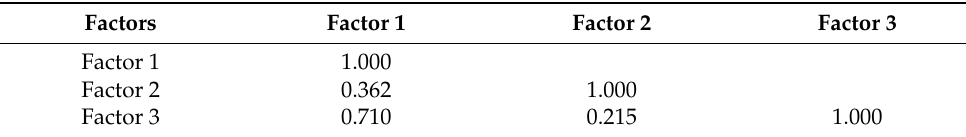
Table 5. Inter-factor correlation matrix.